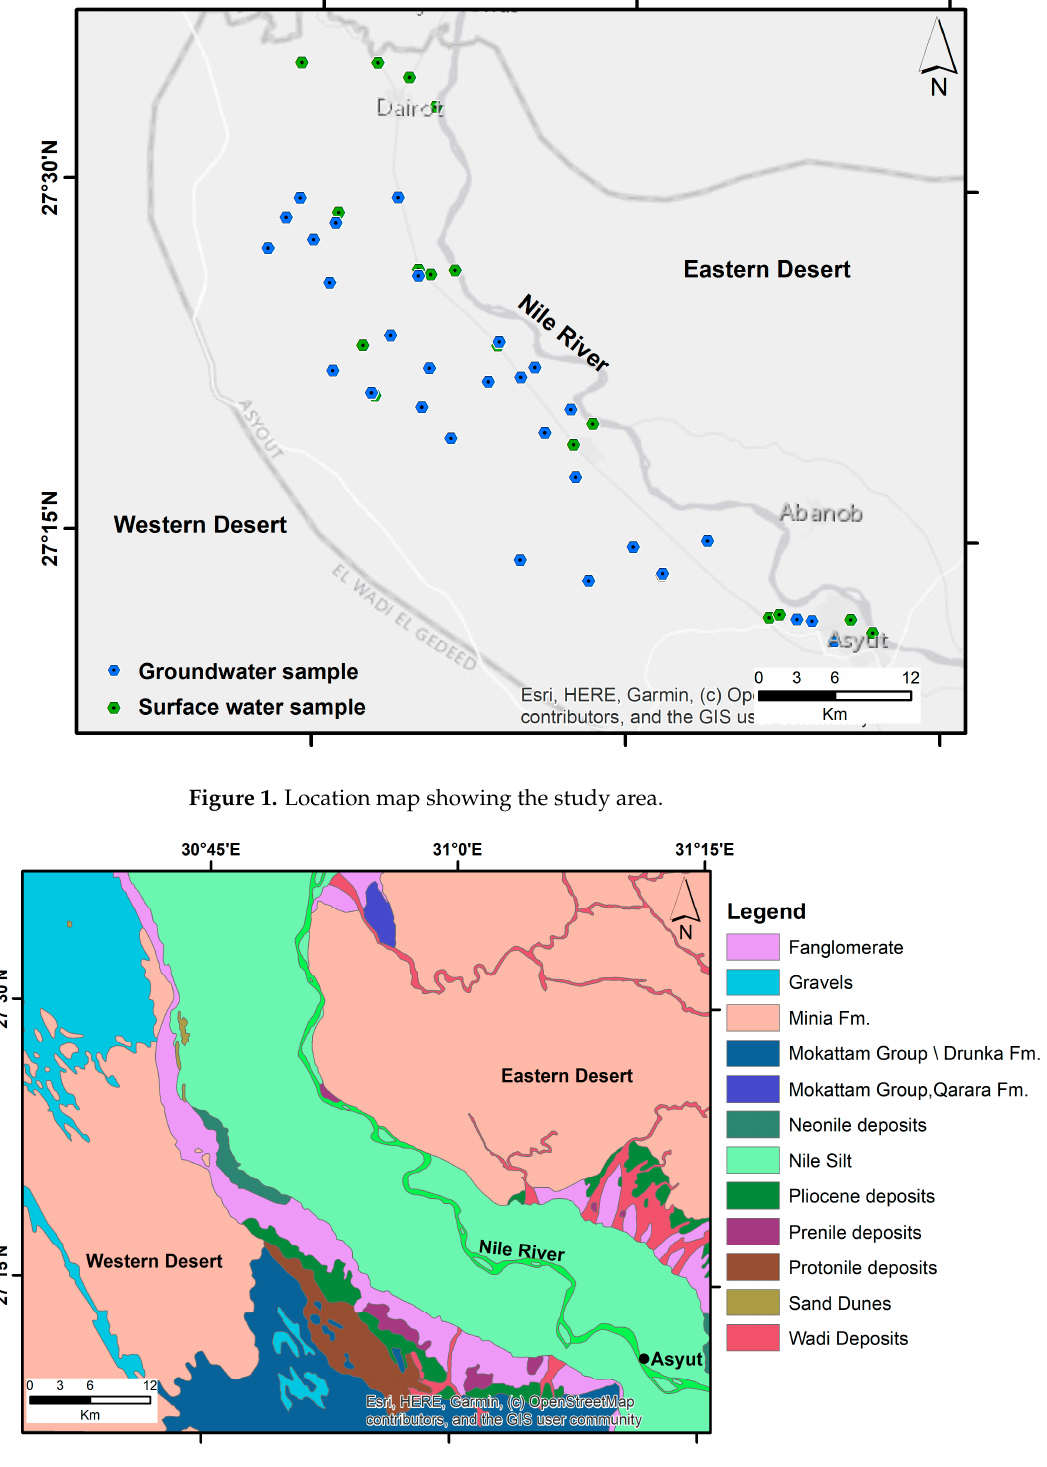
Figure 2. Geological map of the study area (after